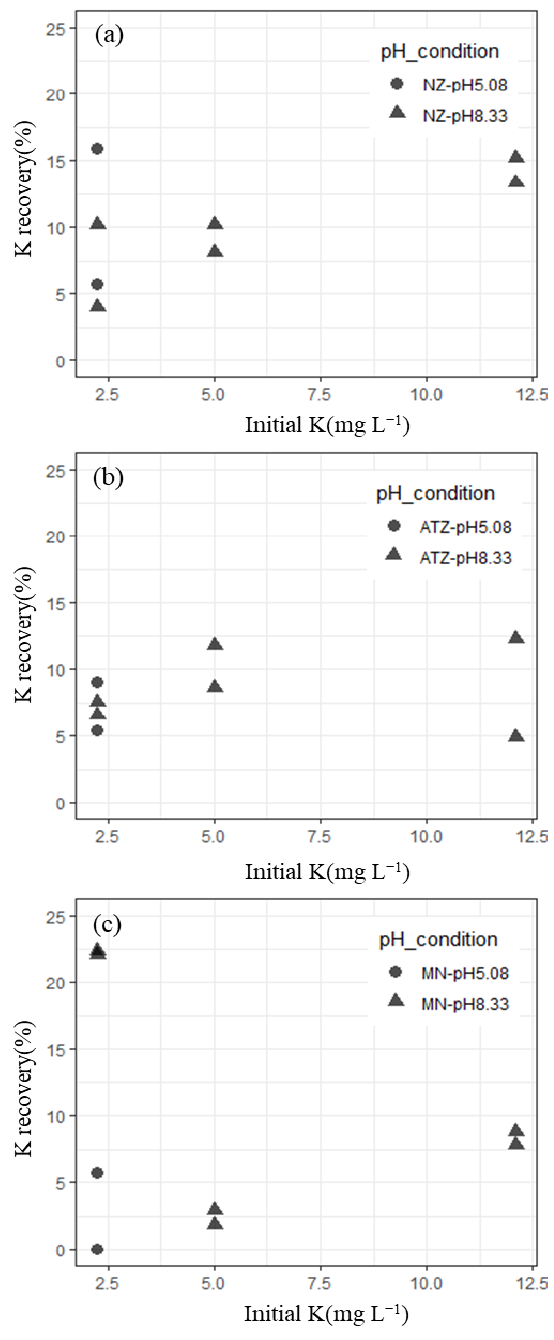
Figure 5. Recovery rate of potassium (K) by ( a ) natural zeolite (NZ), ( b ) ammonium acetate − treated zeolite (TZ), and ( c ) manganese nodule (MN) at various initial K concentrations (i.e., diluted seawater (23 mg L − 1 ), raw seawater (50 mg L − 1 ), and concentrated seawater (120 mg L − 1 )) at different pH conditions (i.e., pH 5.08 ± 0.04 and pH 8.33 ±